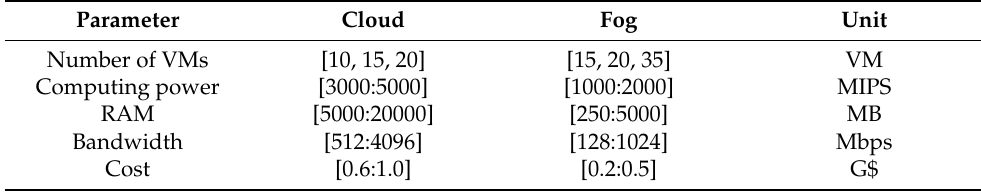
Figure 4. Comparison of energy consumption on CEA-Curie workloads. Figure 5 shows the cost of communication, calculation, and overall execution. These figures show that each job has a different total execution cost. The presented EEOA task scheduling algorithm operates better and outperforms the h-DEWOA, CSDEO, CSPSO, and BLEMO task allocation algorithms in terms of minimizing execution costs. The results obtained further demonstrate the scalability and ability of the suggested approach to schedule large jobs in a heterogeneous environment while incurring the minimum execu- tion costs. For EE01 and EE10 workloads, our proposed EEOA algorithm improves the quality of its solutions by allocating tasks to the finest VMs with the lowest execution costs.